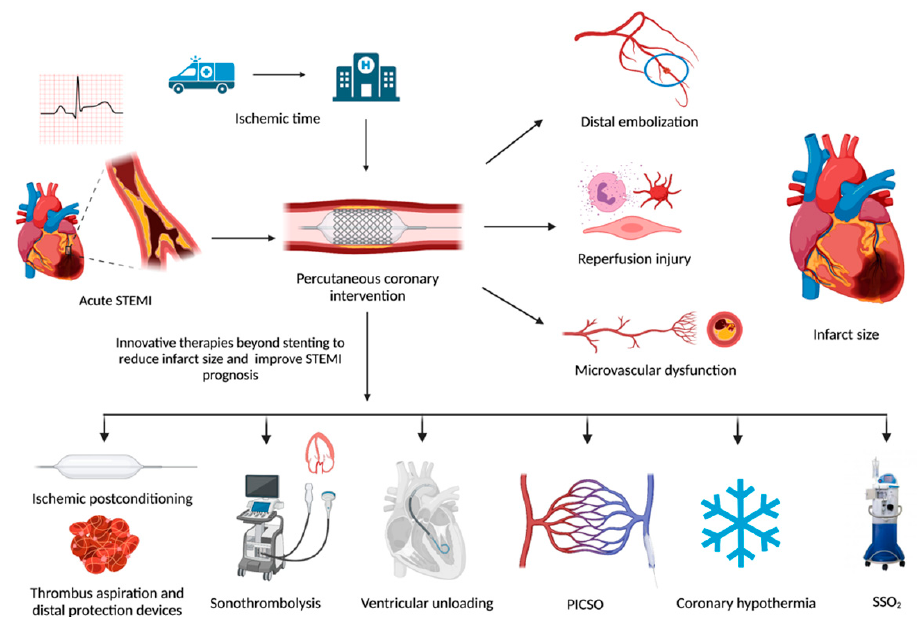
Figure 1. Prognostic determinants involved in infarct size extent and novel interventional strategies to enhance myocardial recovery in STEMI patients. STEMI: ST-segment-elevation myocardial infarction; PICSO: Pressure-controlled intermittent coronary sinus occlusion; SSO 2 : Supersaturated oxygen. Created with BioRender.com.